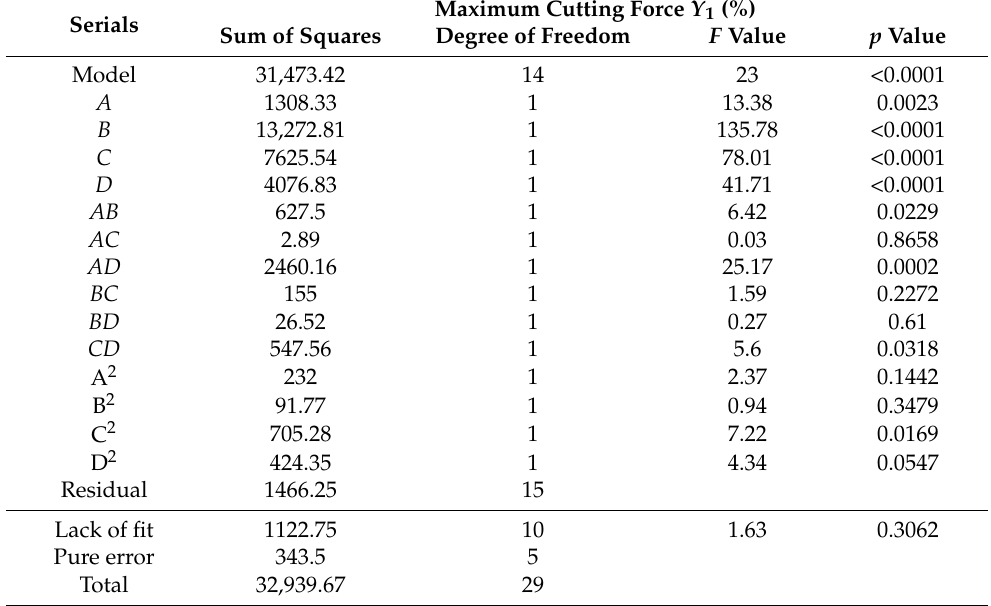
Table 5. Variance